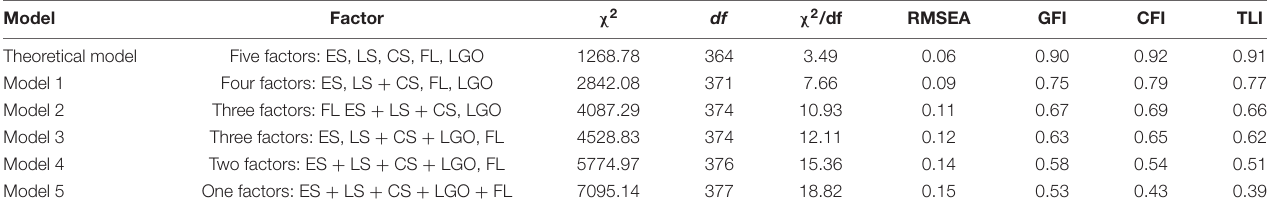
TABLE 1 | Comparison of measurement model.